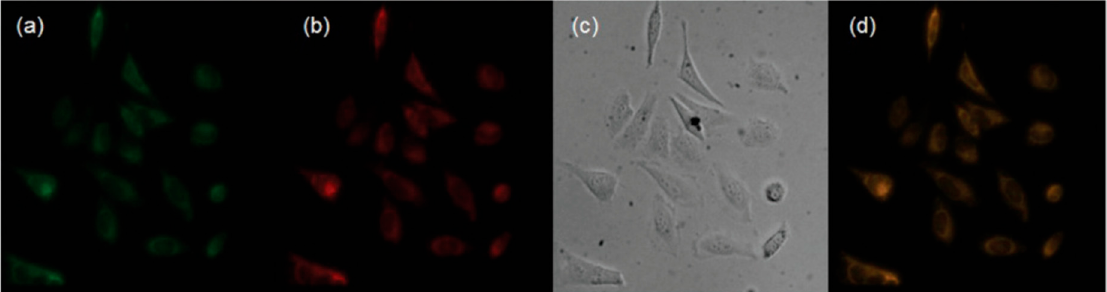
Figure 6. Localization of 60 in mitochondria of HeLa cells. 60 (5 μ M) and MitoTracker Green FM (200 nM) were loaded into HeLa cells: ( a ) fluorescence image of MitoTracker Green FM (excitation: 488 nm, emission: 450–550 nm); ( b ) fluorescence image of 60 with Fe 3+ (excitation: 515 nm, emission: 550–650 nm); ( c ) bright-field of HeLa cells; ( d ) merged image (Reproduced from Ref. [68] with permission from The Royal Society of Chemistry).